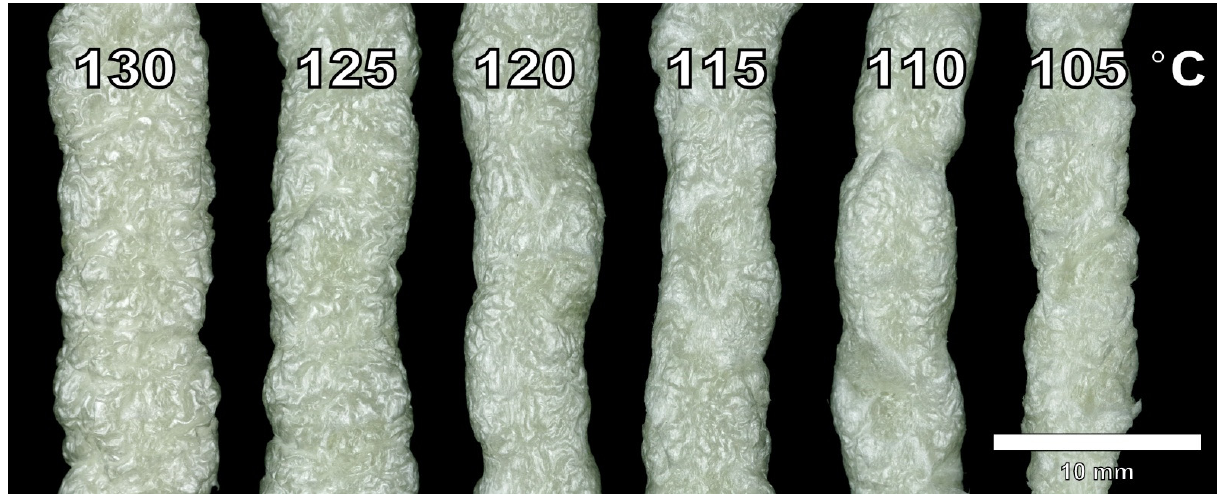
Figure 6. Side profiles from the produced cellulose palmitate foams using different foaming temperatures and 3% IB as a blowing agent. Refer to Table 3. The scale is approximate.